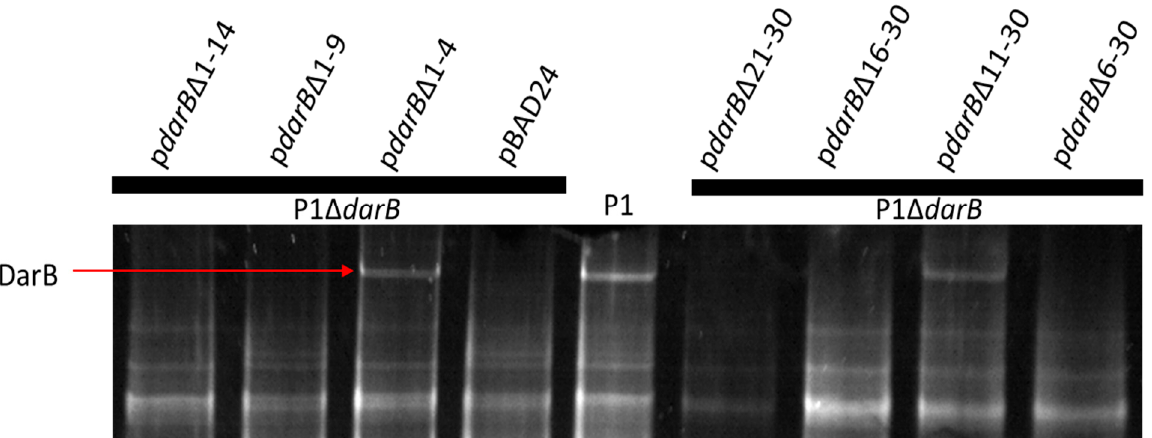
Figure 3. The ability of DarB truncations to localize to the P1 capsid. Truncations of DarB residues 1–4 and 11–30 are tolerated, which would suggest amino acids 6 through 10 are required to localize DarB to the P1 virion. However, deletion of residues 16–30 and 21–30 also inhibit DarB packaging, suggesting that other deletions may induce improper folding of the N-terminus that inhibits recruit- ment of DarB to the P1